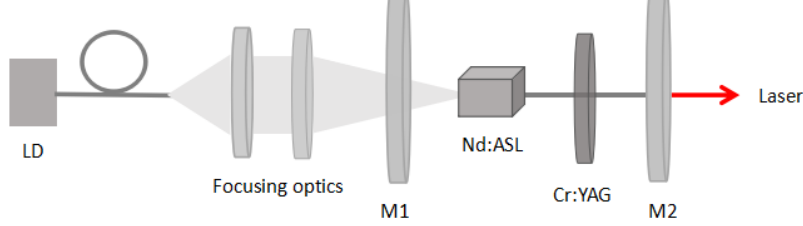
Figure 4. Continuous-wave (CW) and Q-switched laser setup of the Nd:ASL crystal.